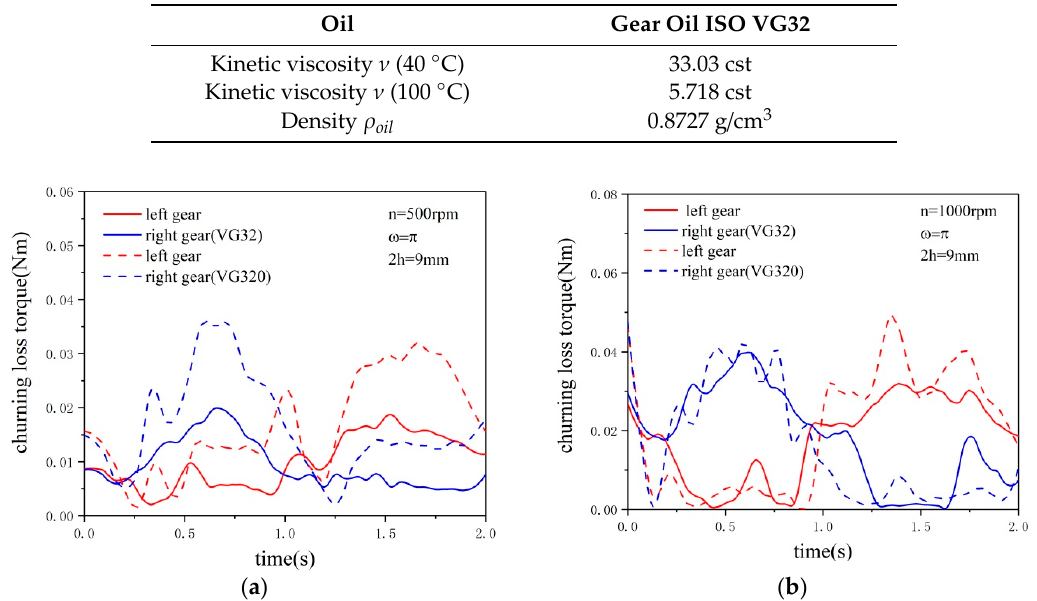
Table 4. Physical and chemical properties of lubricating oil VG32.